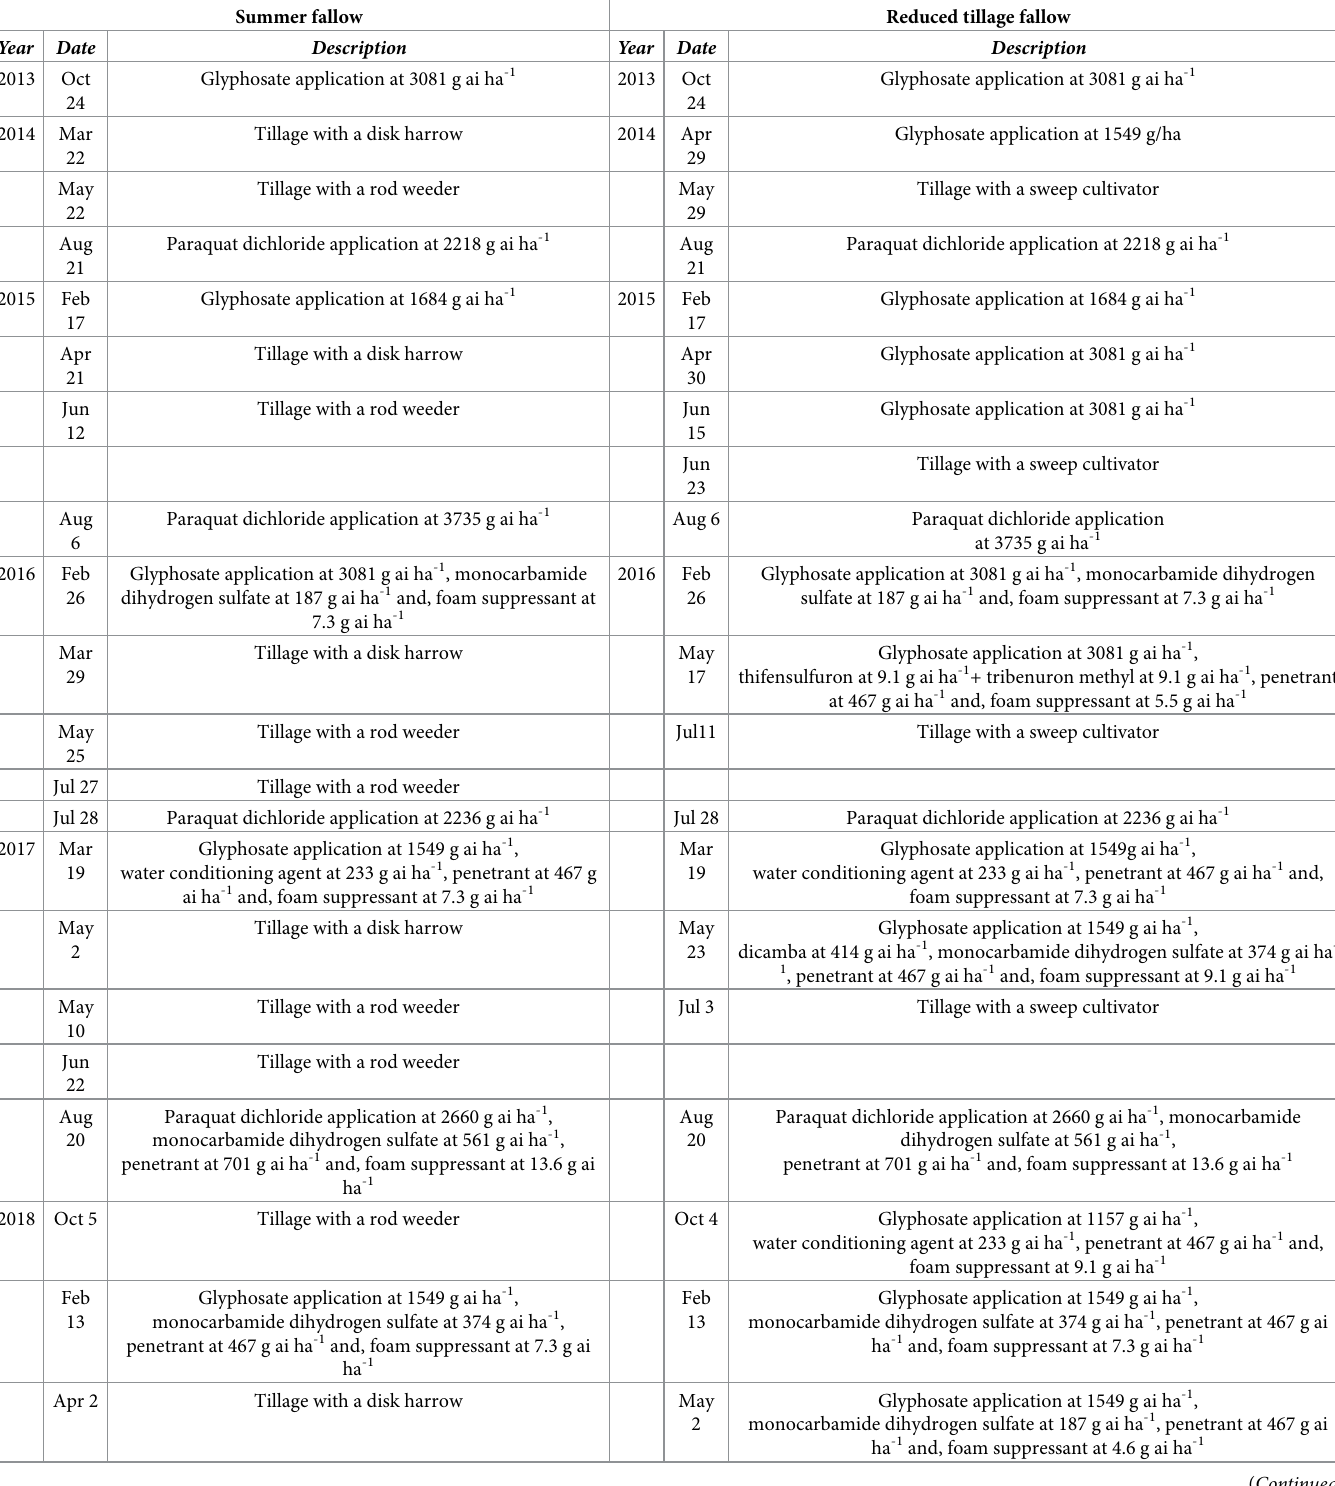
Table 2. Weed management in the fallow year of the two cropping